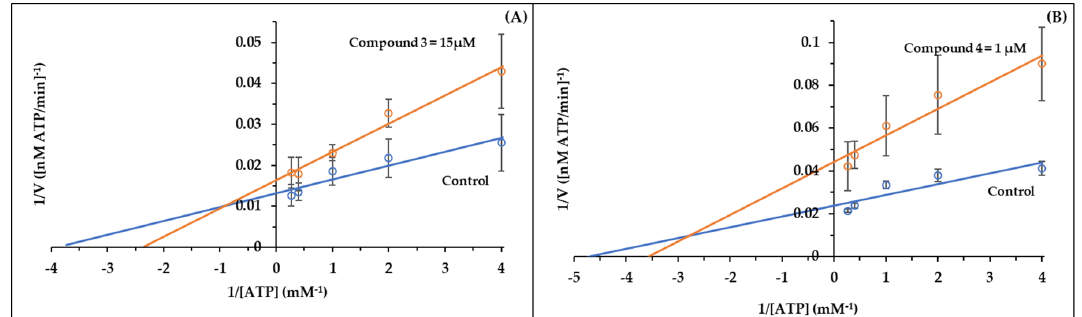
Figure 5. Lineweaver-Burk plots of Ca 2 + -ATPase activity in the absence (blue) and in the presence (orange) of 1 or 15 µ M of the gold compounds ( A ) Gold compound 3 ; ( B ) Gold compound 4 . The plots were used for determining the type of enzyme inhibition. The gold complexes presented a mixed type of inhibition. Data are plotted as means ± SD. The results shown are the average of triplicate experiments carried out in distinct preparations.